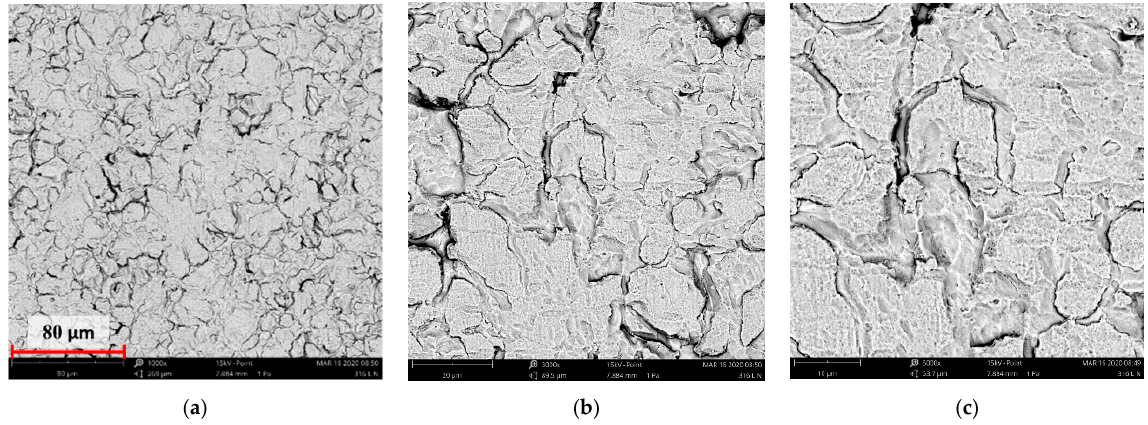
Figure 5. SEM image of the sample implanted with nitrogen ions: ( a ) ×1000, ( b ) ×3000, ( c ) ×5000.